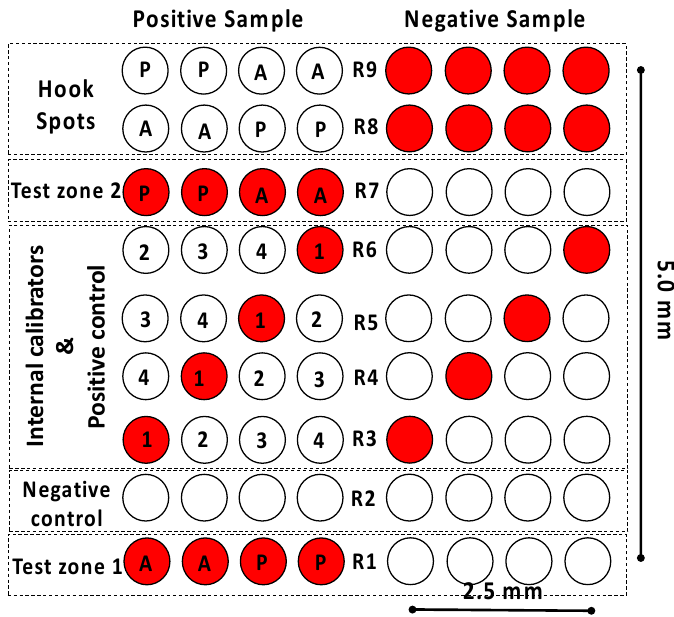
Figure 2. Schematic representation of the microarray layout, representing the expected results of positive and negative samples. In test zones 1 and 2, the antibody against almond (A) and peanut proteins (P) are immobilized in rows R1 and R7, respectively, bovine serum albumin (negative control) in row R2, the secondary antibody against rabbit IgG (internal calibrators 1–4) in rows R3-R6, and almond and peanut proteins in rows R8 and R9 (hook spots).